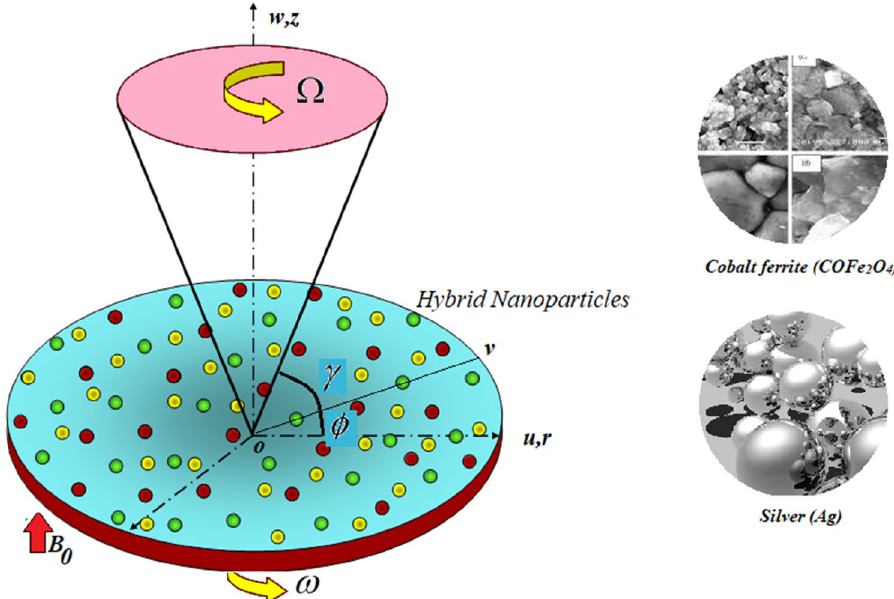
Figure 1. Flow geometry of the